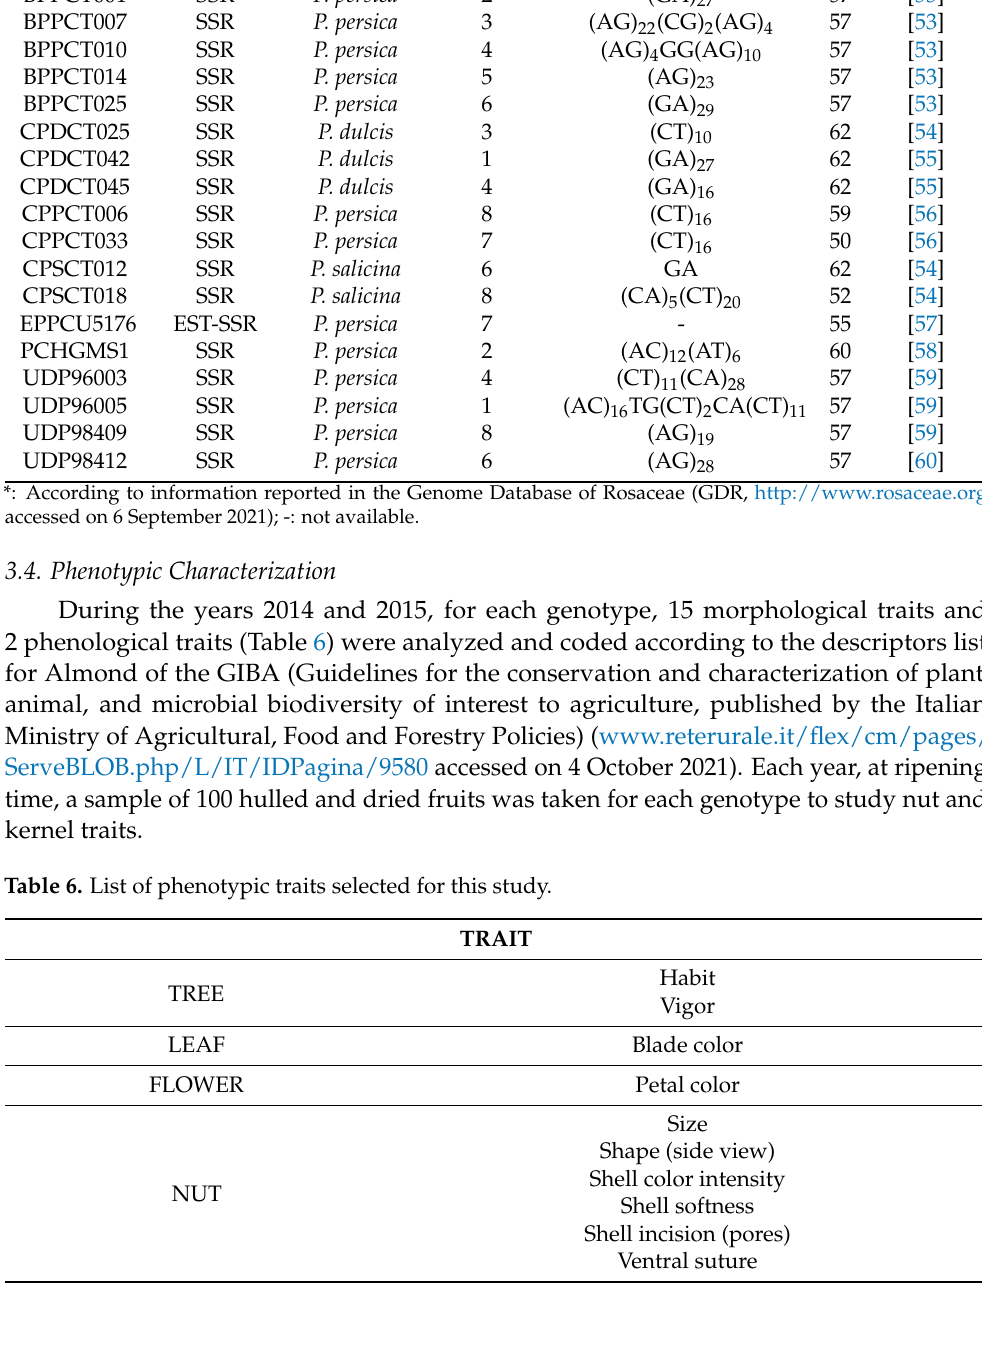
Table 5. List of microsatellites used in this study. Locus type, species of origin ( Prunus spp), almond linkage group (LG), repeat motif and annealing temperature (Ta in ◦ C) are specified. SSR Locus Type